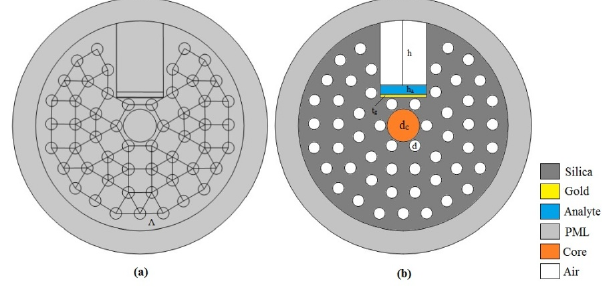
FIGURE 1. (a) Geometrical structure of the proposed PQF. (b) Sensor schematic